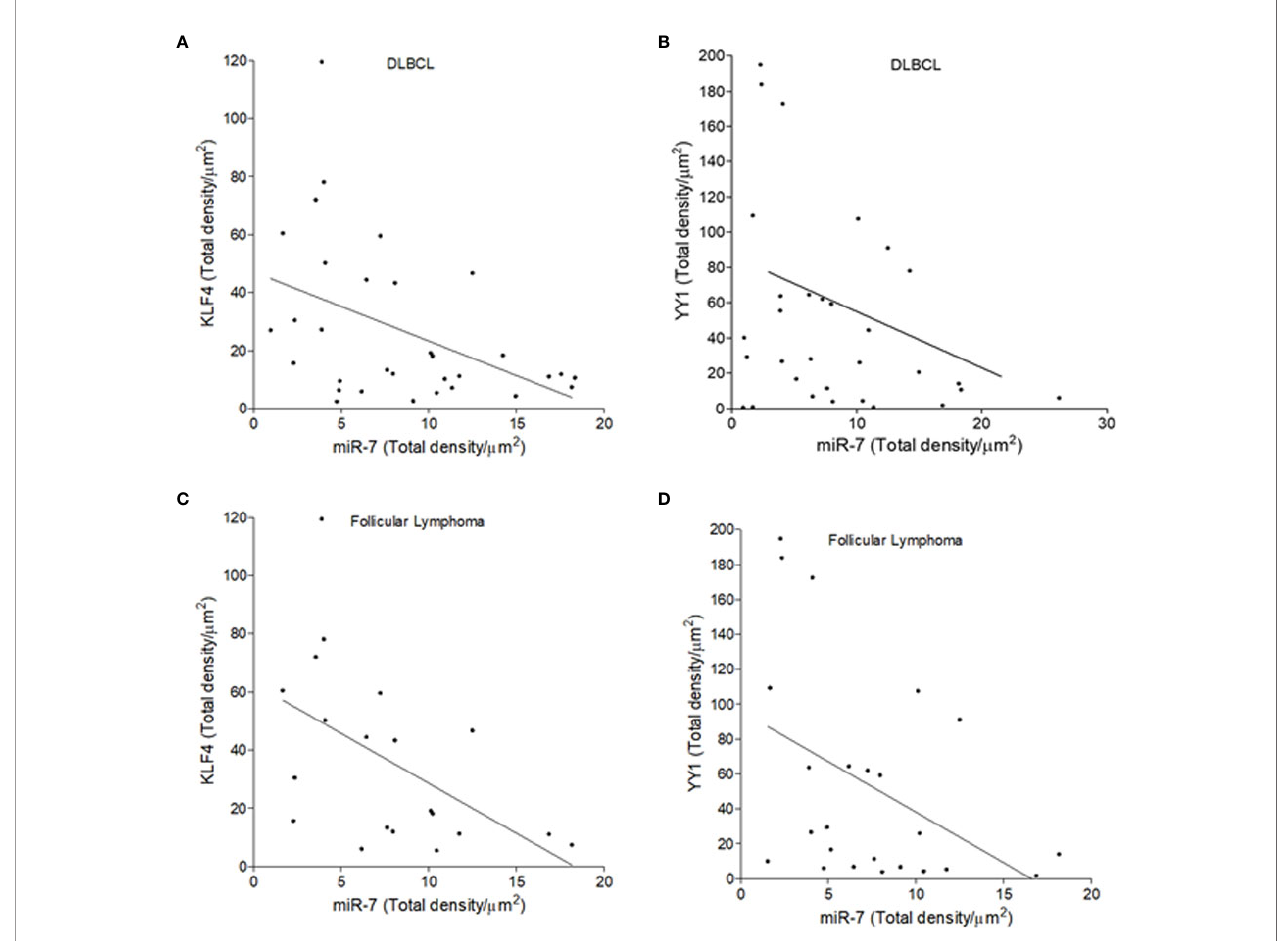
FIGURE 5 | Inverse expression correlation of miR-7 vs YY1/KLF4 in non-Hodgkin lymphoma (NHL) tissues. (A – D) Correlation of the expression of YY1 vs miR-7, or KLF4 vs miR-7 in DLBCL and follicular lymphoma was analyzed, respectively. Expression correlation analysis of miR-7 vs KLF4/YY1 was evaluated by Pearson correlation in DLBCL (A) (r=-0.4454 p=0.0106) and (B) (r=-0.3415 p=.0301) or follicular lymphoma (C) (r=-0.5229 p=0.0180) and (D) (r=-0.4248